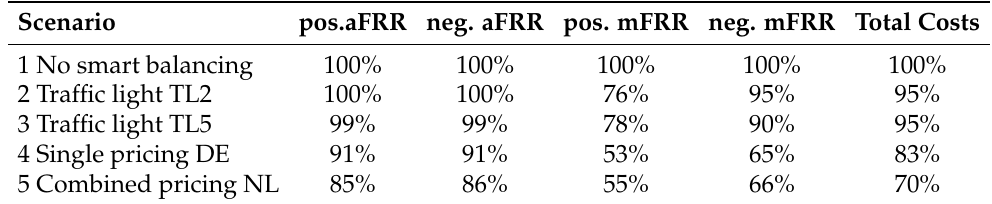
Table 8. Smart balancing simulation: activated FRR energy and total costs of scenarios with historic ACE and pay-as-bid clearing.